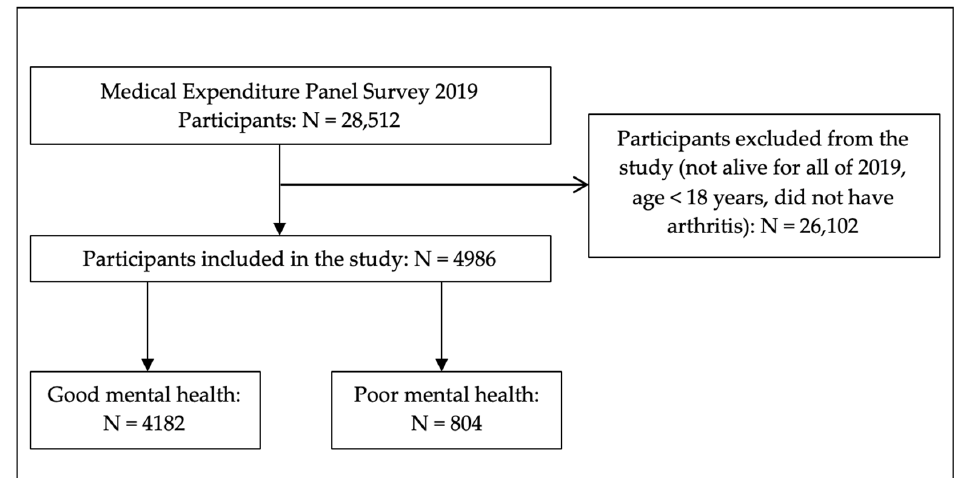
Figure 1. Number of participants included in the study.